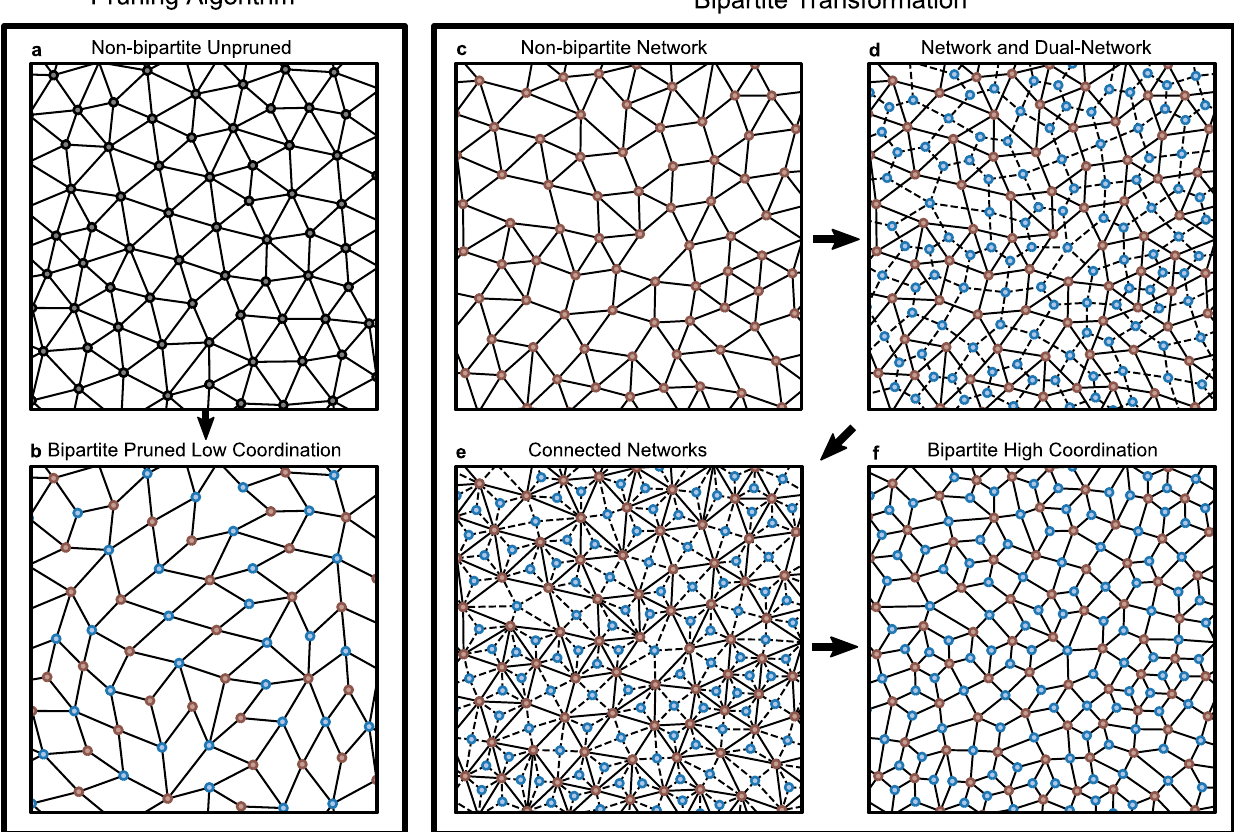
Fig. 5 Two methods to build random bipartite planar graphs. Both start from an isotropic contact amorphous network 14,56 . a Starting network with a high coordination z = 6. b Pruned version of the previous network, the bonds between pairs of odd cycles have been removed, adding them together into even cycles. The result is a bipartite planar graph. c Starting random planar contact network, in this case the coordination is z = 5. d We compute the dual graph of the network (blue nodes and dashed lines), place each node of the dual graph inside its corresponding cycle. e Then disconnect each node of the dual graph (blue to blue nodes), and reconnect them to the nodes corresponding to the vertices of its cycle in the original graph (red and blue nodes connected by dashed lines). f Lastly remove the connections of the original graph (red to red nodes) and keep the connections between the dual graph and the original graph. As both initial graphs are independent sets that don ’ t connect to themselves, the result is a random planar bipartite